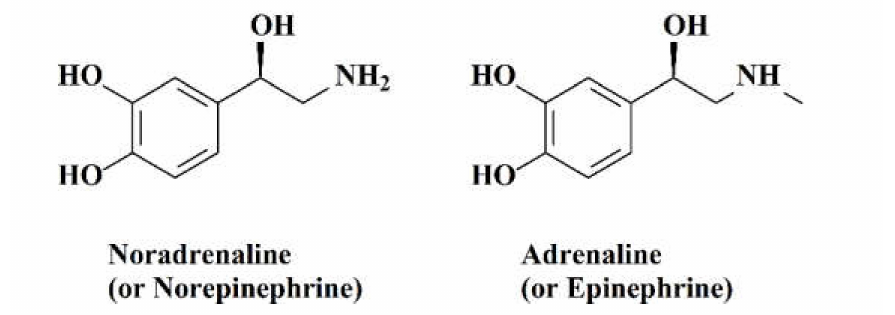
Figure 1. Chemical structures for the evaluated